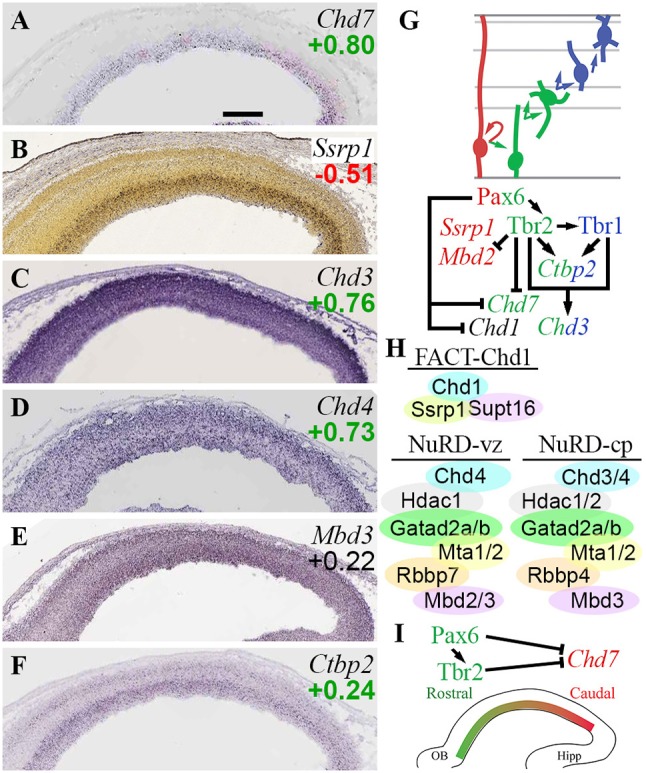
CHD chromatin remodeling complexes. (A–F) Expression of indicated genes. ISH: Genepaint (A,C–F) and Allen Brain Atlas Developing Mouse Brain (B). Scale bar: 100 μm. (G) Gene expression and regulation. Notably, Tbr1 and Tbr2 synergistically activate Chd3, a NuRD subunit. (H) CHD complexes in E14.5 neocortex include FACT-Chd1 in RGPs, and NuRD in progenitors (Chd4-containing) and neurons (Chd3/4-containing). (I) Gradient of Chd7 expression (high caudal) is shaped by Pax6 and Tbr2.